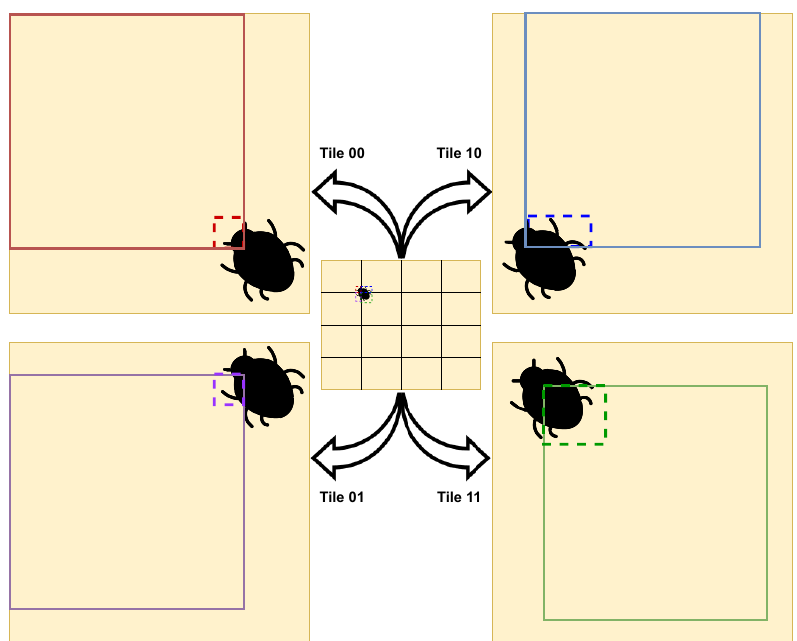
Figure 4. Illustration of splits without overlapping the split